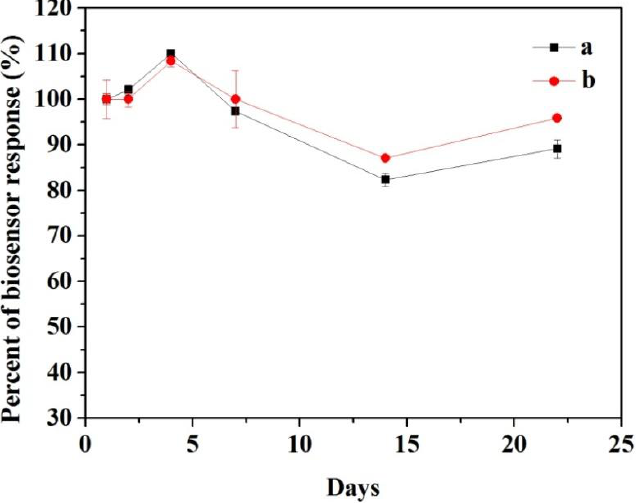
Figure 10. The long-term stability of the response of ( a ) CNFs/Lac/Nafion/GCE and ( b ) Cu/CNFs/Lac/Nafion/GCE. Conditions: scan rate 100 mV s −1 , pH 5.5(a), pH 6.0 (b). The error bars indicate the standard error for three measurements with the same